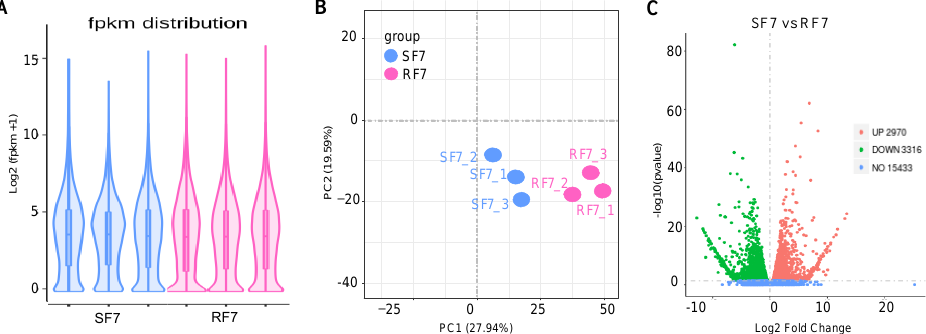
Figure 5. RNA-Seq comparison analysis of watermelon gene expression in resistance and sensitivity varieties: ( A ) The violin diagram of FPKM distribution; ( B ) PCA analysis of different samples; ( C ) Volcano map of DEGs between resistant and susceptible cultivars. Note: SF7, Susceptible cultivar + FON, 7 days post inoculation (7 dpi); RF7, Resistant cultivar + FON, 7 days post inoculation (7 dpi). Three independent replicates.